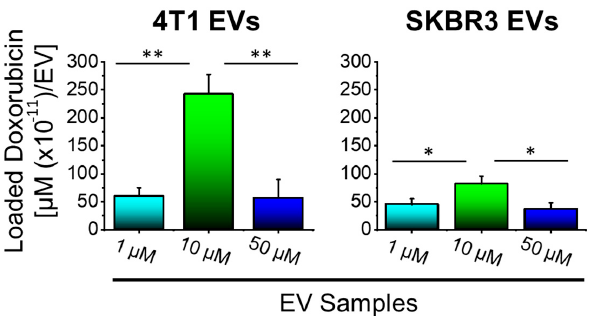
Figure 3. 10 µ M Dox enhances drug loading into 4T1 and SKBR3 cell-derived EVs. An effective